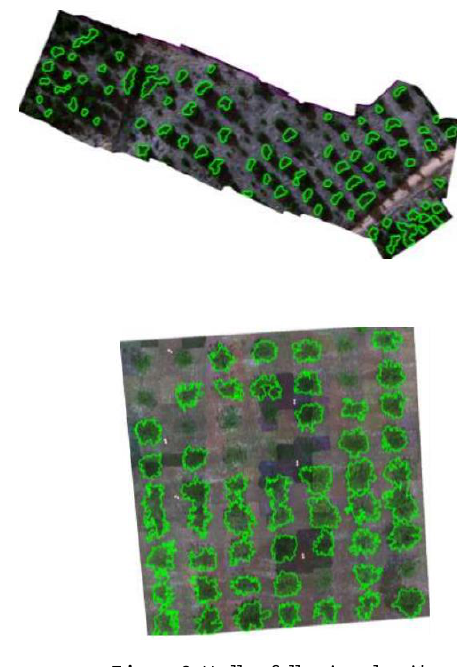
Figure 6. Local maxima algorithm